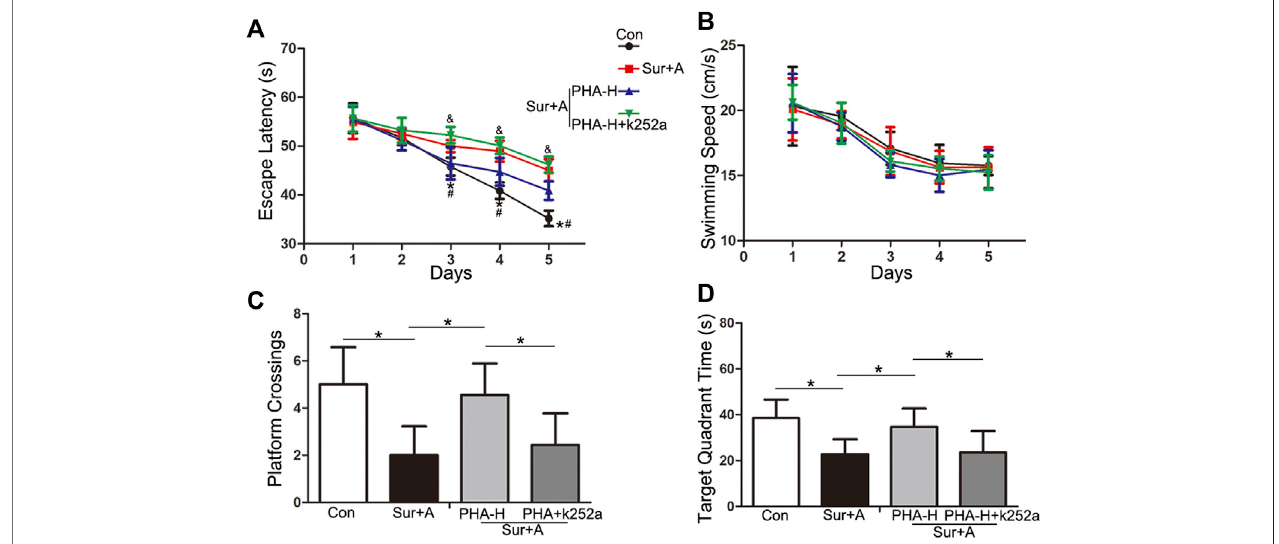
FIGURE 5 | Effects of α 7nAChR modulation on hippocampal-dependent spatial learning and memory, following surgery and anesthesia in aged mice. The MWM testconsistsof5 days-spatialacquisitiontrials (A , B) and1 day-probetrials (C , D) .Dataarepresentedasmean±SD. (A) Escapelatencytoreachtheplatform.* p < 0.05 versus the control groups, # p < 0.05 versus the surgery plus anesthesia group, & p < 0.05 versus the K-252a group. (B) Average swimming speed of each group during theacquisitionphase. (C) Thenumberofplatformcrossingswitha60-slimit foreach groupintheprobetrials. (D) Time spentinthetarget quadrantforeachgroup with a 60-s limit for each group in the probe trials. * p < 0.05 Con, Control; Sur+A, Surgery plus Anesthesia; PHA-H, high-dose PHA (0.6 mg/kg).